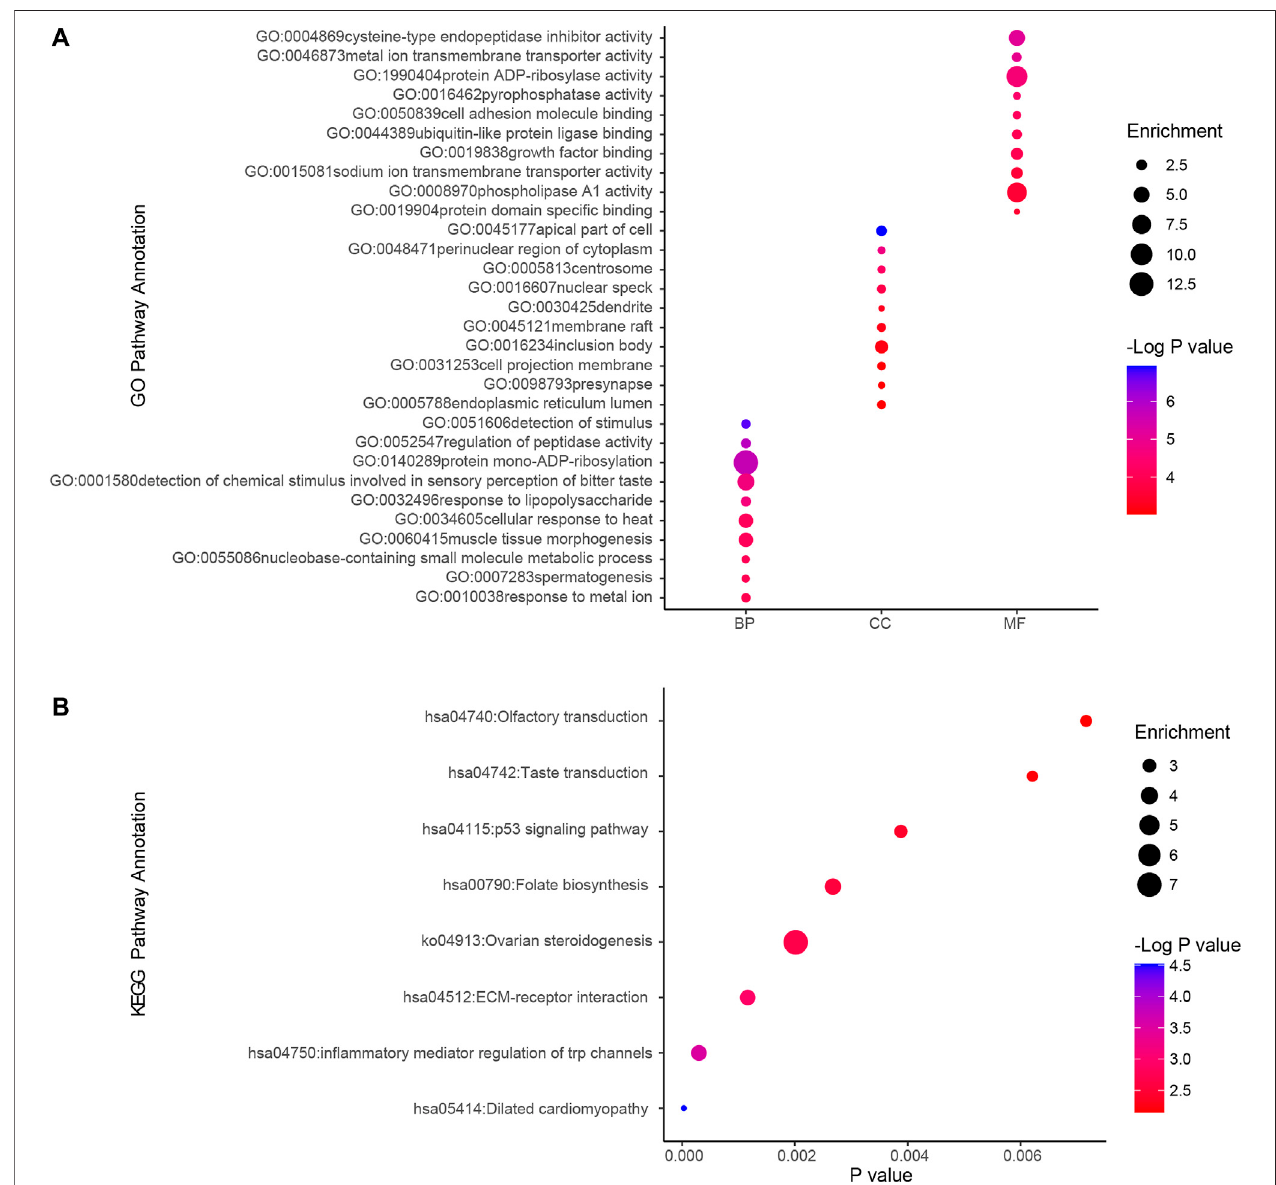
FIGURE 2 | GO and KEGG cluster pathway analysis of candidate genes.Gene ontology (GO) and Kyoto Encyclopedia of Genes and Genomes (KEGG) pathway enrichmentanalysisbyusingClusterPro fi ler. (A) GOanalysisdepictedthesigni fi cantlyenrichedGOtermsfortop10enrichedgenesetsfromcandidategenes.Horizontal axis denoted different groups. The vertical axis represented strikingly enriched GO pathway names. BP, Biological Process; CC, Cellular Component; MF, Molecular Function. (B) KEGG analysis depicted the signi fi cantly top10 enriched GO terms for the top enriched gene sets from overlapping genes. The horizontal axis represented the respective − Log10 (corrected p -value) of distinct pathways relative to the other displayed terms. The vertical axis represented considerably enriched KEGG pathway names. The color represented the p -values relative to the other displayed terms (Blue was more meaningful). Size of round node was in proportion to gene ratio of the enriched gene